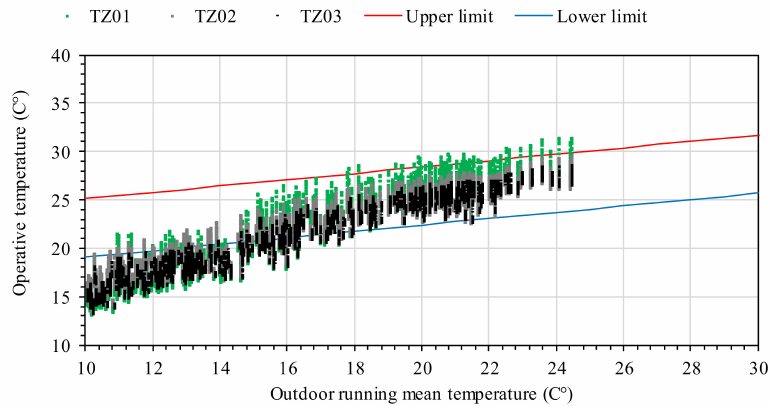
Figure 12. Thermal comfort analysis using EN16798-1 for Scenario